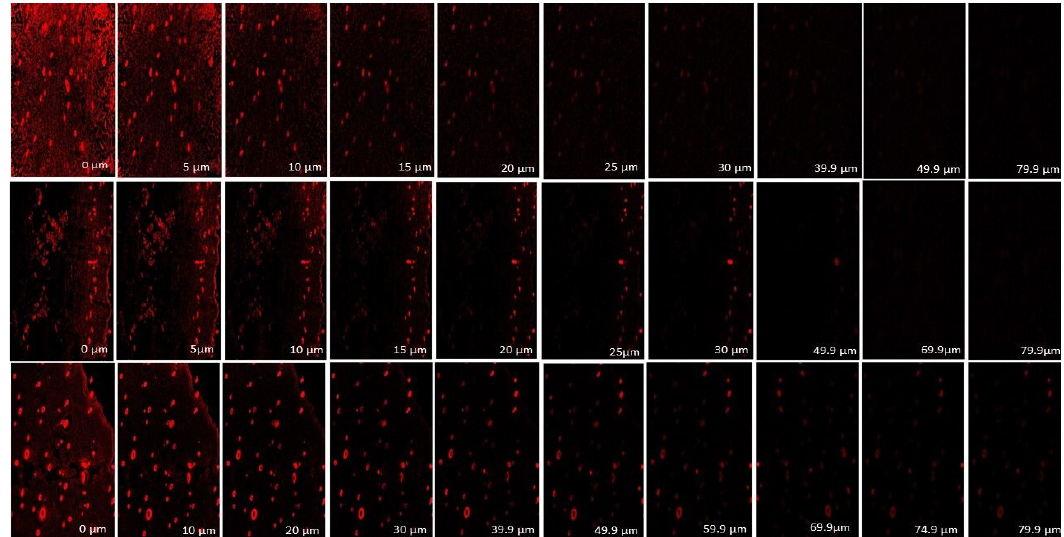
Figure 13. CLSM image of the skin showing skin permeation of the rhodamine B from rhodamine B solution (1st row), rhodamine B-loaded conventional gel (2nd row) and rhodamine B-loaded ethoso- mal gel (3rd row). The red colour indicates the fluorescence intensity produced by the rhodamine B dyes entrapped inside the skin layers.